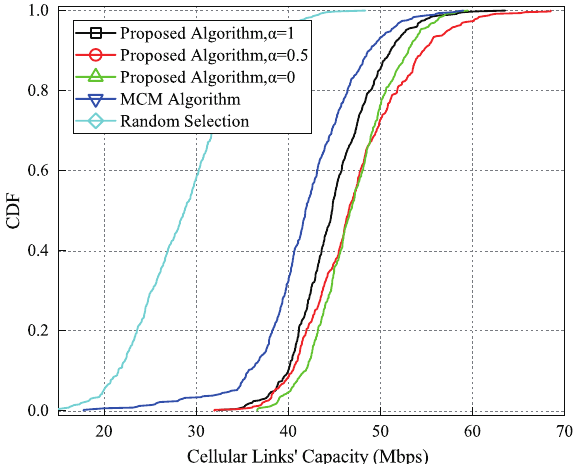
Figure 5. The CDF of achievable total CUEs’